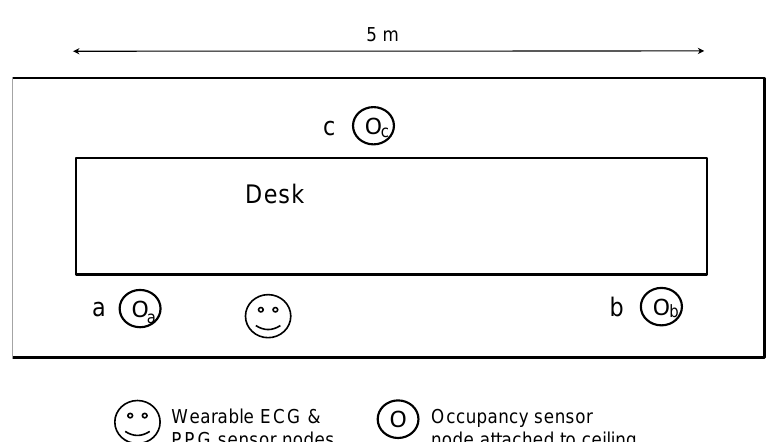
Figure 3. Sensor deployment.